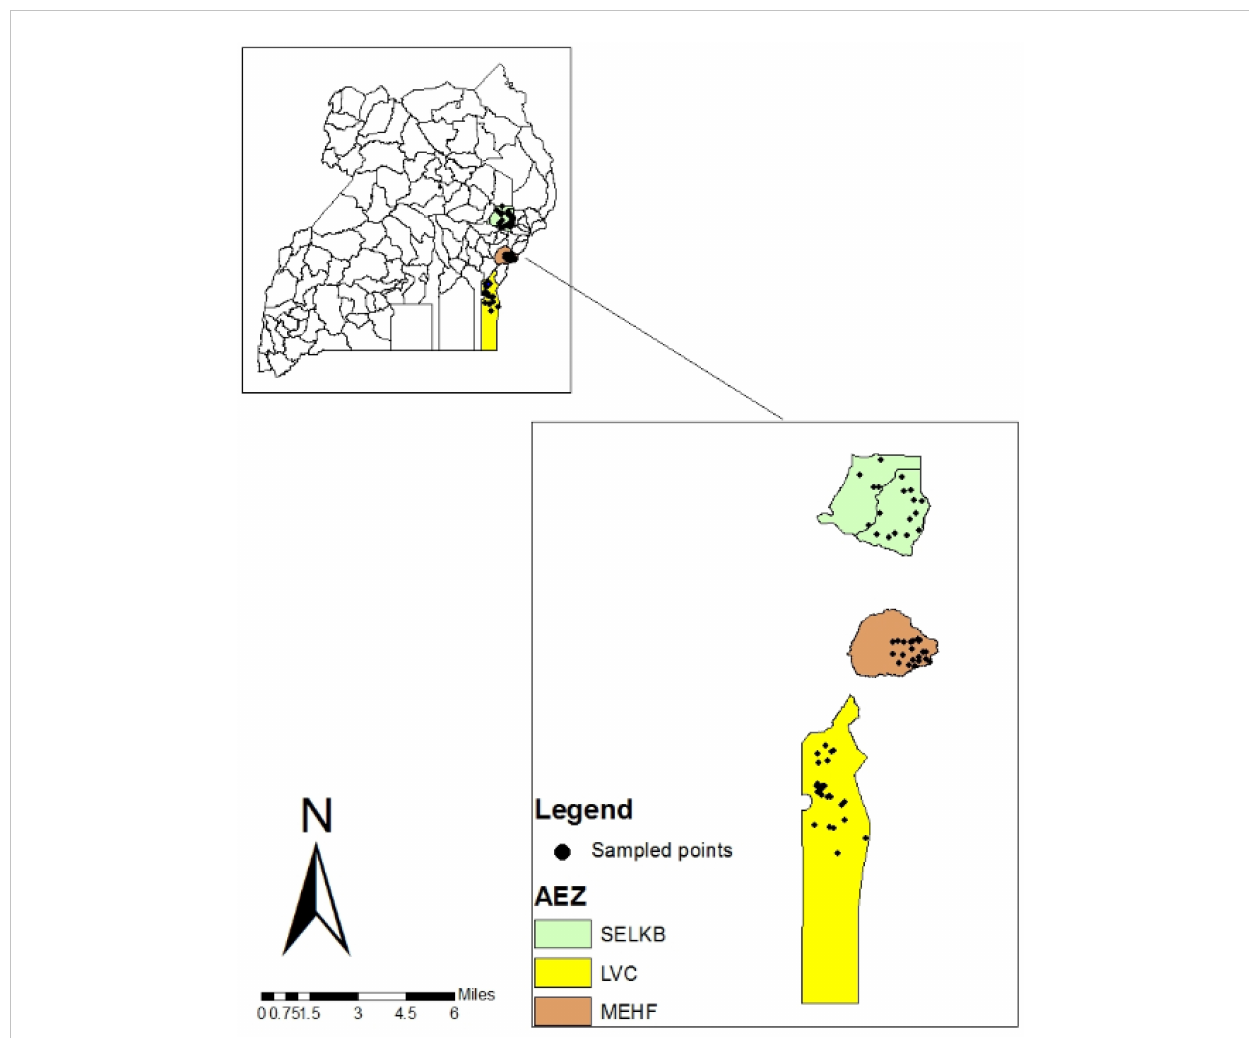
FIGURE 1 A map showing study areas in eastern Uganda. SELKB, Southern and Eastern Lake Kyoga Basin; MEHF, Mt. Elgon High Farmlands; LVC, Lake Victoria